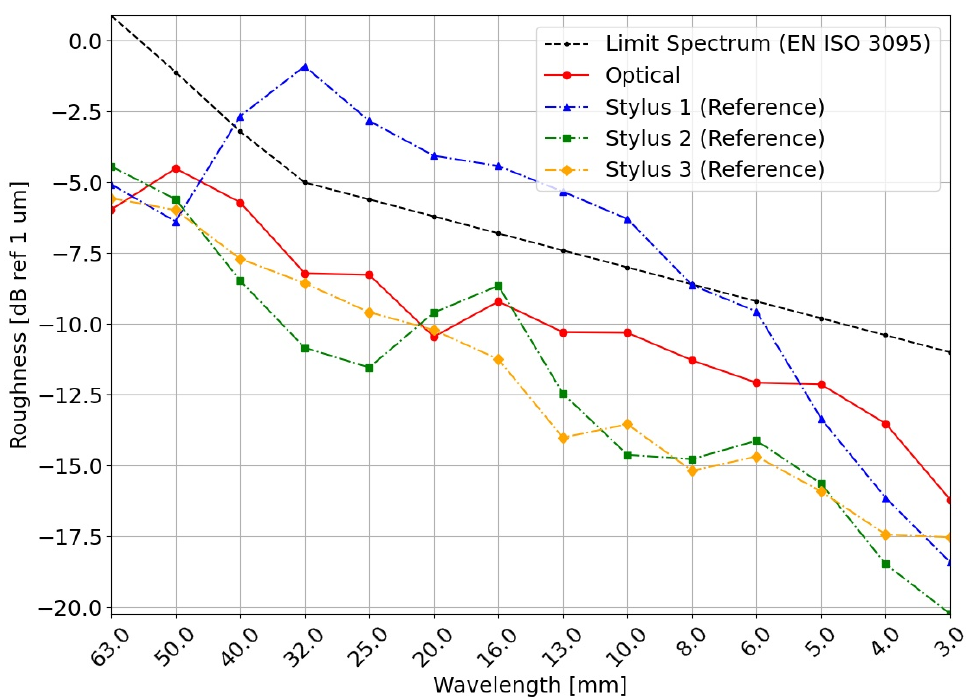
Figure A3. Spectrum of acoustic roughness for measurement of the optical system at 50 km h − 1 , compared with reference section A and the limit spectrum from EN ISO 3095 [22].